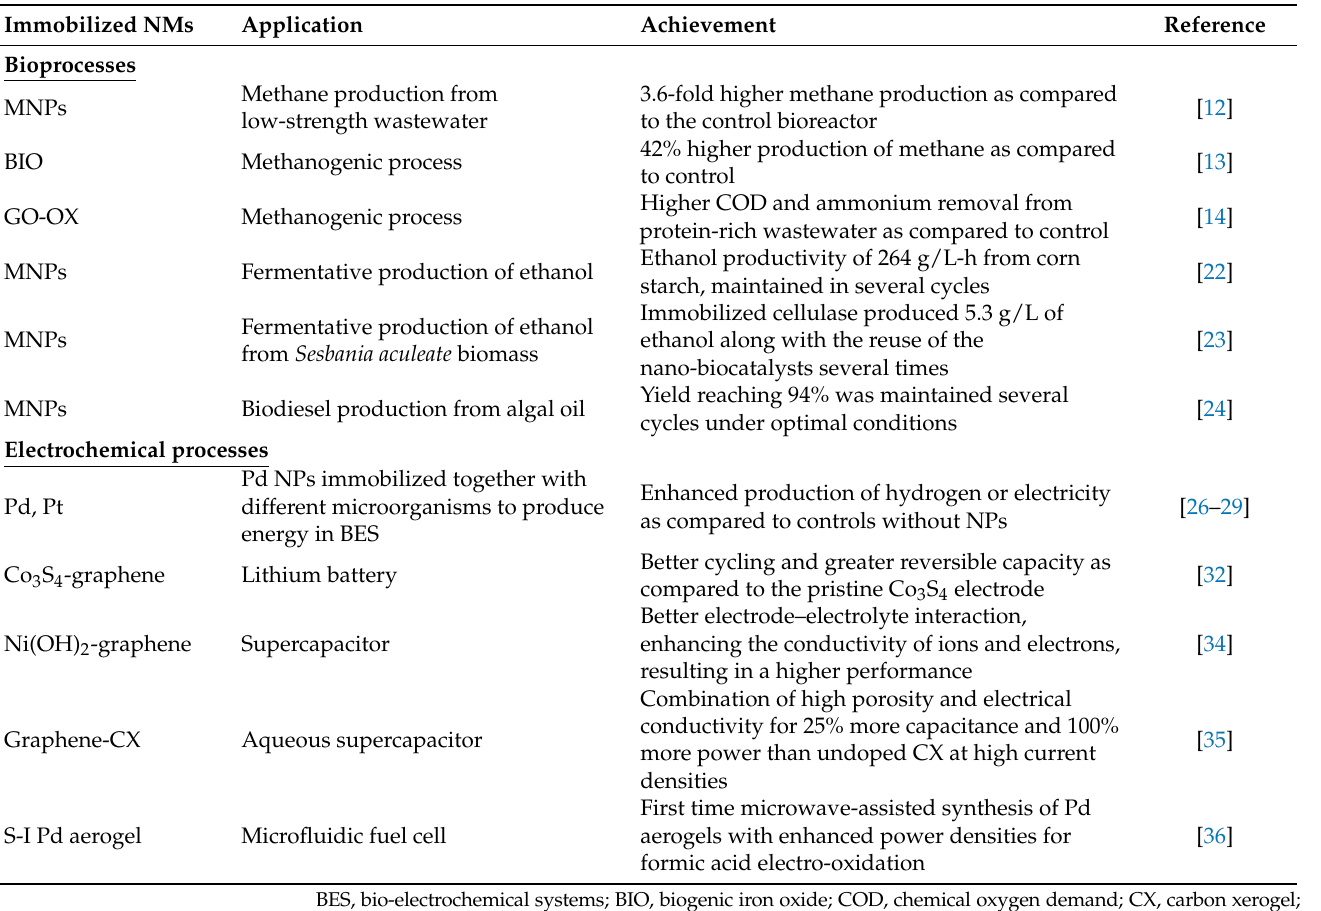
Table 1. Application of immobilized nanomaterials for energy